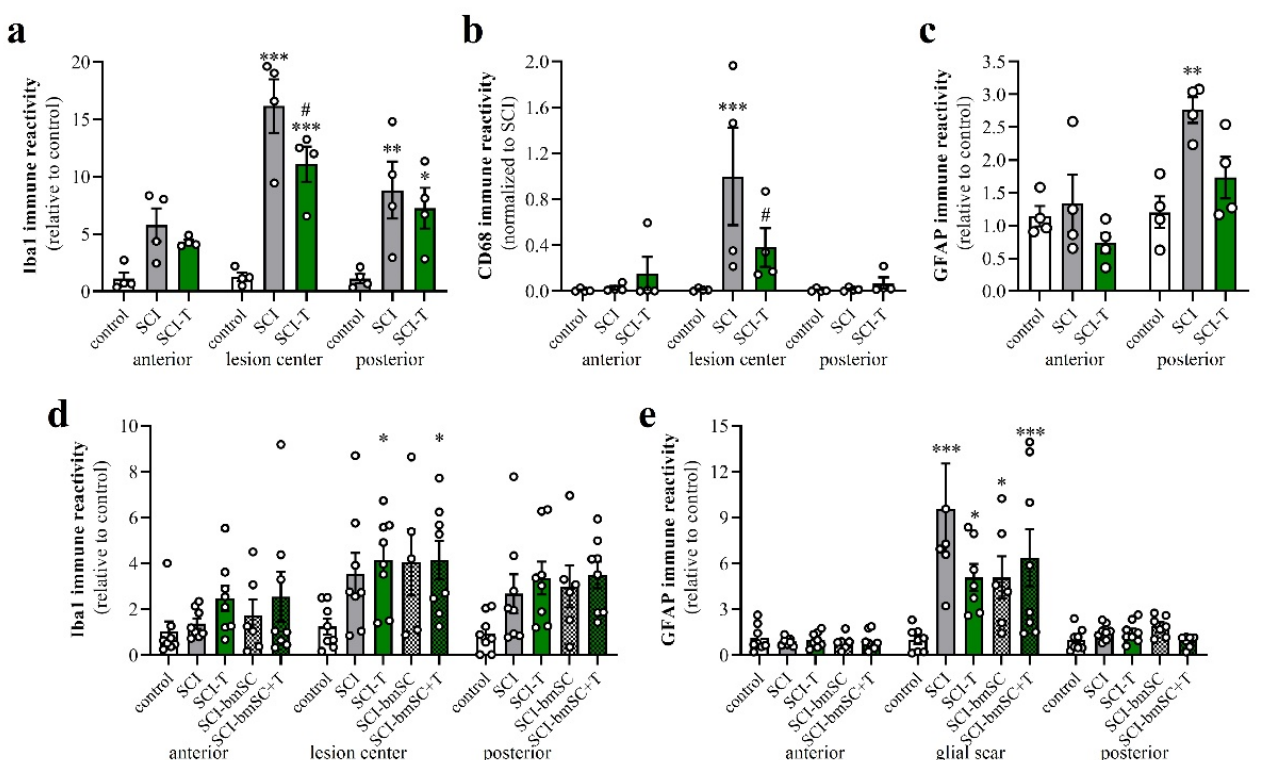
Figure 9. Activation of macrophages, microglia and astrocytes after SCI. Data from spinal cord areas were normalized for IR in the anterior position of sham-operated animals and analyzed with 2-factor ANOVA followed by post hoc Sidak tests. ( a ) Quantification of Iba-1 IR (fluorescence integrated density) at 4 dpo in white matter at 8 mm anterior, 8 mm posterior of the lesion site and in the lesion center [2-factor ANOVA, location effect: F (2, 27) = 11.7, p < 0.01; treatment effect: F (2, 27) = 29.9, p < 0.001; interaction: F (4, 27) = 3.2, p < 0.05]. ( b ) Quantification of CD68 IR at 4 dpo in areas 8 mm anterior and posterior of the lesion site and in the lesion center [2-factor ANOVA, location effect: F (2, 27) = 6.7, p < 0.01; treatment effect: F (2, 27) = 3.3, p = 0.05; interaction: p < 0.05; data were normalized to SCI, lesion center, as almost no CD68 cells are found outside this area]. ( c ) Quantification of GFAP at 4 dpo in white matter at 8 mm anterior, 8 mm posterior of the lesion site [location effect: F (1, 18) = 14.2, p < 0.01; treatment effect: F (2, 18) = 6.6, p < 0.01; interaction: F (2, 18) = 3.4, n.s.]. ( d ) Quantification of Iba-1 IR at 6 W in white matter 8 mm anterior, posterior and in the lesion center site [location effect: F (2, 98) = 5.9, p < 0.01; treatment effect: F (4, 98) = 5.4, p < 0.001; interaction: F (8, 98) = 0.3, n.s.]. ( e ) Quantification of GFAP IR at 6 W in white matter 8 mm anterior and posterior of the lesion center and in the glial scar [location effect: F (2, 97) = 36.1, p < 0.001; treatment effect: F (4, 97) = 4.1, p < 0.01; interaction: F (8, 97) = 2.5, p < 0.001]. Significant differences detected with post hoc comparisons tests ( p < 0.05, p < 0.001, p < 0.001) are indicated with *, **, *** for SCI vs. control and # SCI vs. SCI-T600].